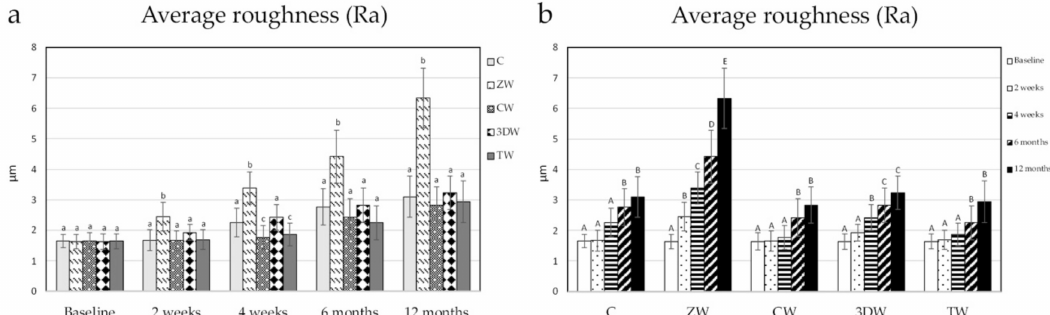
Figure 1. ( a ) Mean L*a*b* value before staining. ( b ) Mean L*a*b* value after staining relative to baseline showed no statistical differences among groups ( p > 0.05).